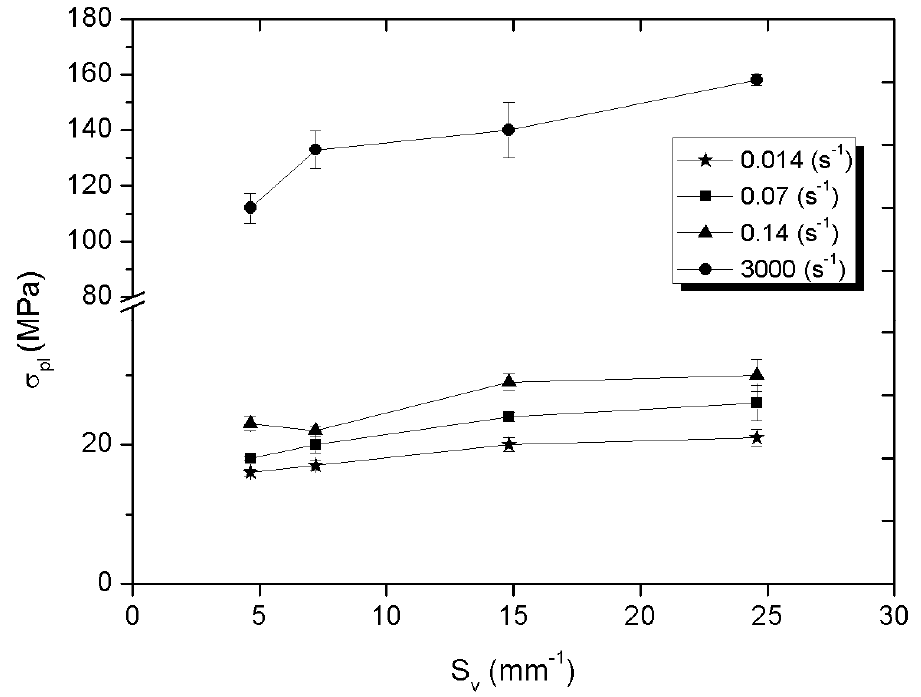
Figure 10. Plateau stress of ceramic-elastomer composites depending on S v parameter for 1.4 · 10 − 3 , 7 · 10 − 2 , 1.4 · 10 − 1 , and 1 · 10 3 s − 1 strain